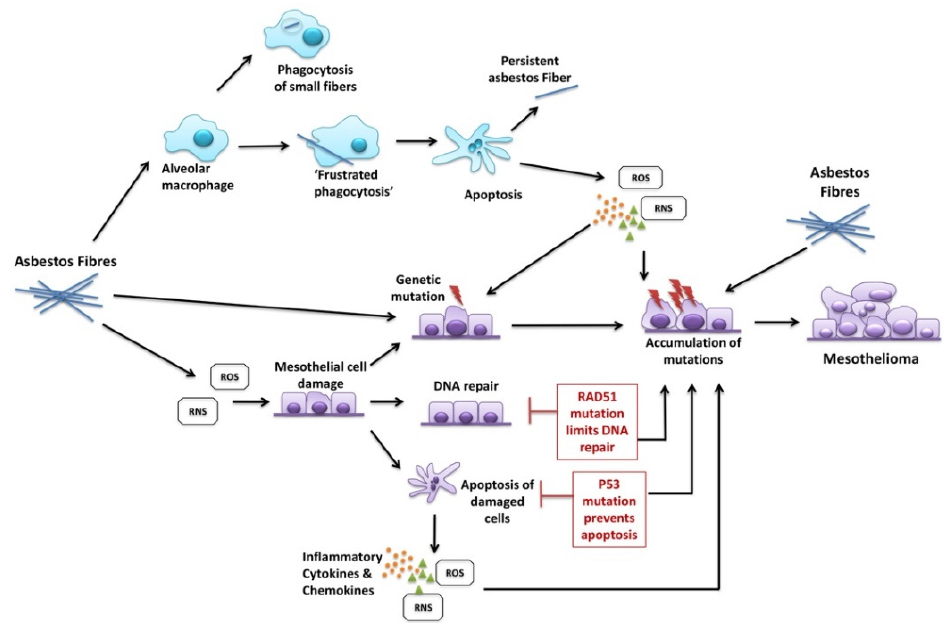
Figure 1. Chronic inflammation after asbestos inhalation causes DNA damage, leading to mutations and the proliferation of malignant cells. Apoptosis acts as a protective mechanism, removing damaged—and possibly malignant—cells. The genetic compromise in DNA repair and reduced effectiveness of the protective apoptotic mechanisms that normally safeguard the cell from malignant transformation would increase the speed at which mutations